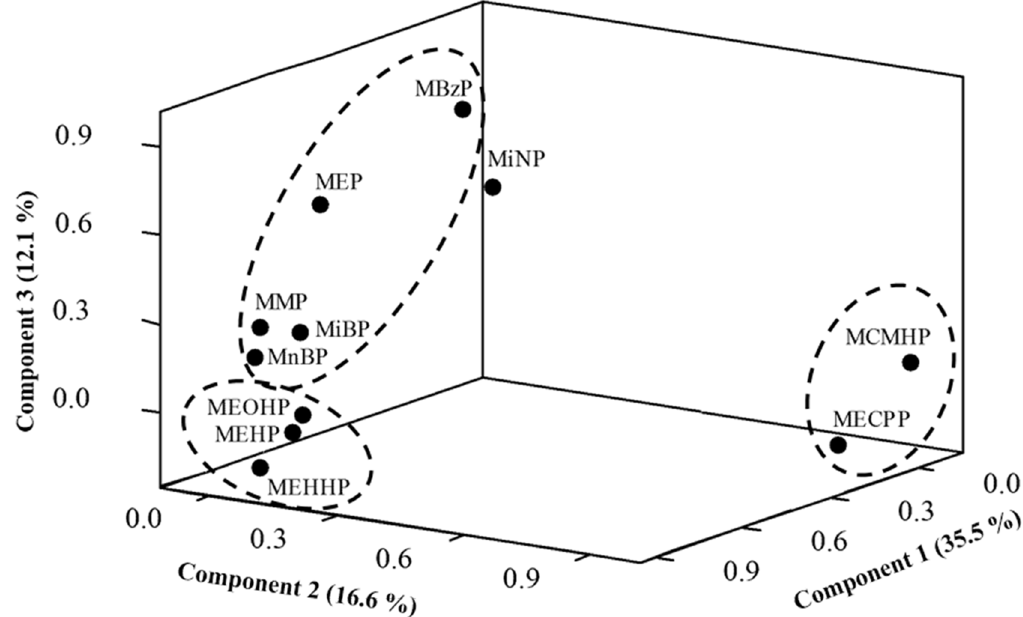
Fig 2. Principal component analysis of 11 urinary phthalate metabolites in 97 pregnant Taiwanese